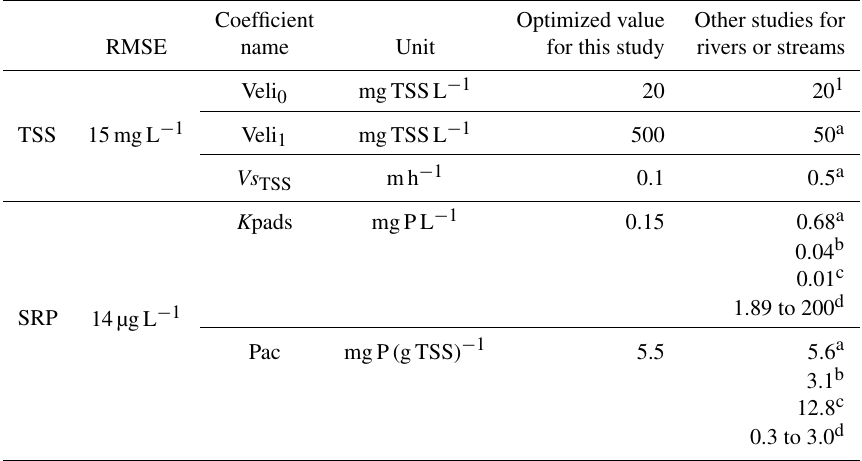
Table 1. Values optimized for TSS and Langmuir coefficients during the calibration step and compared to other values found in literature. Coefficient Optimized value Other studies for RMSE name Unit for this study rivers or streams Veli 0 mgTSSL − 1 20 20 1